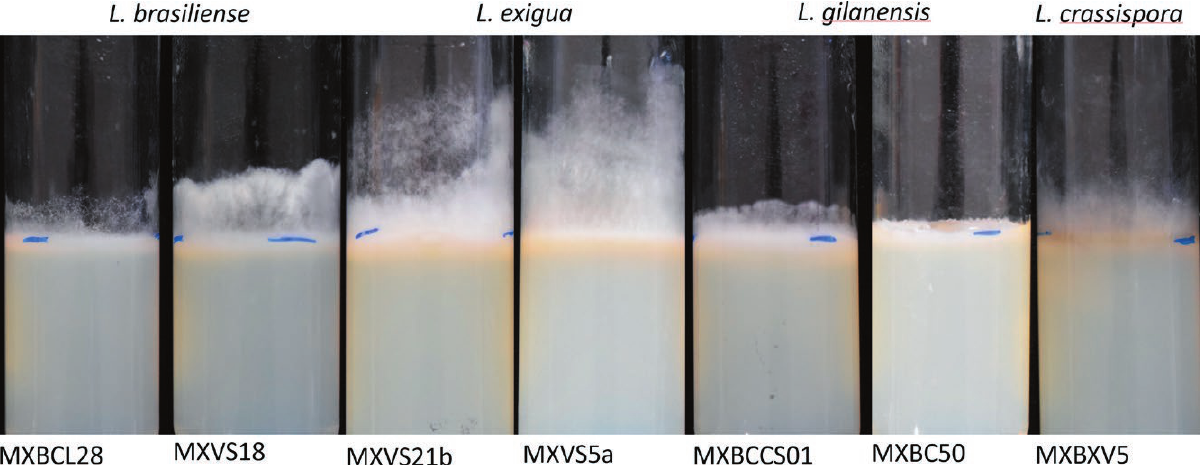
Figure 5. Aerial mycelium growth of different Lasiodiplodia spp. isolated from grapevines in Mexico. The isolates were grown in glass tubes containing PDA medium for 5 d at